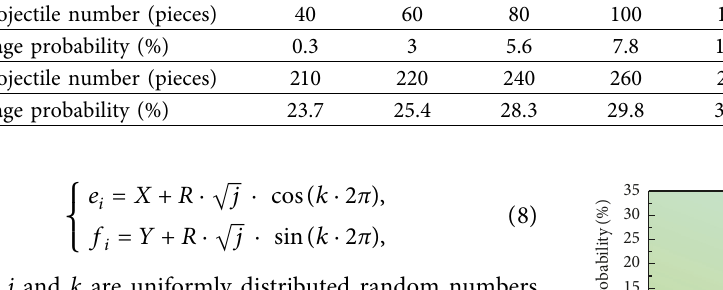
Table 6: Influence of the number of subprojectiles on the blockage probability.